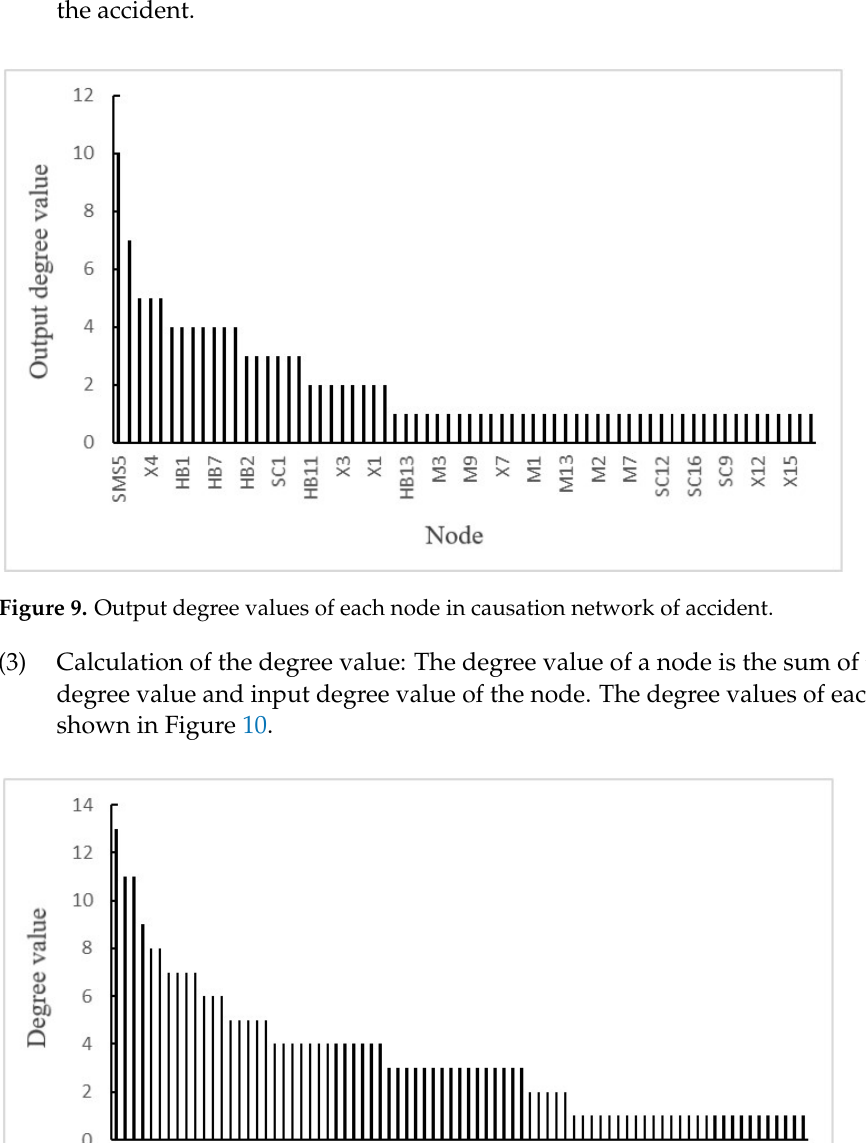
Figure 9. Output degree values of each node in causation network of accident.